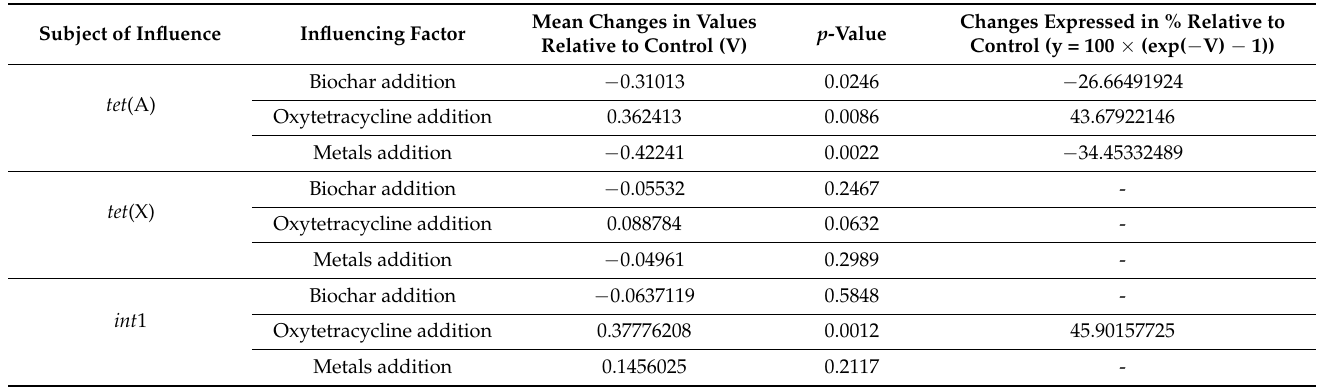
Table 2. The influence of the additives (biochar, oxytetracycline, metals) on the number of copies of the tet (A), tet (X), and int 1